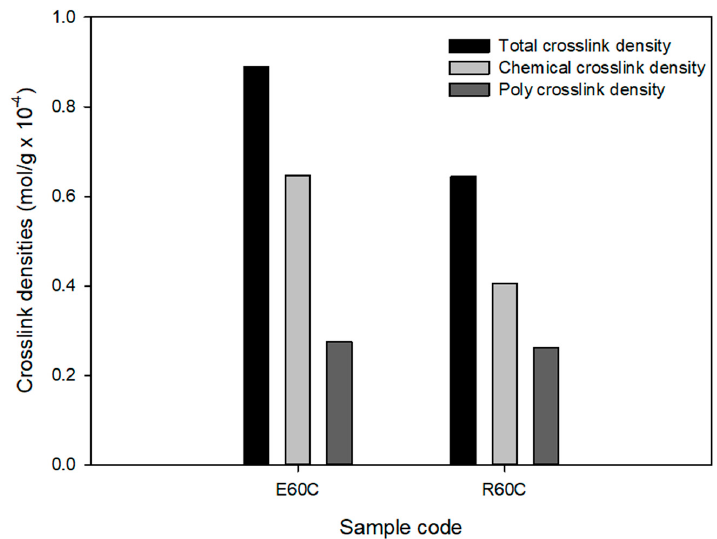
Figure 6. Cure characteristics of emulsion styrene butadiene rubber (ESBR) and reversible addition ‐ fragmentation radical transfer (RAFT) ESBR carbon black ‐ filled compounds.